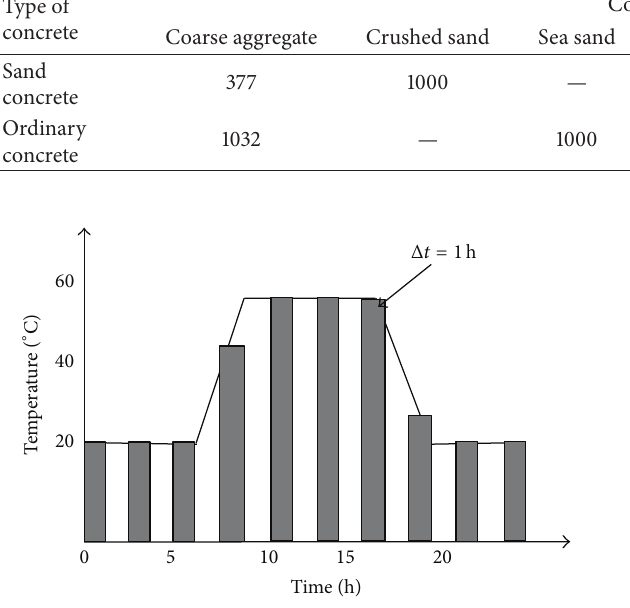
Figure 2: History of the temperature.